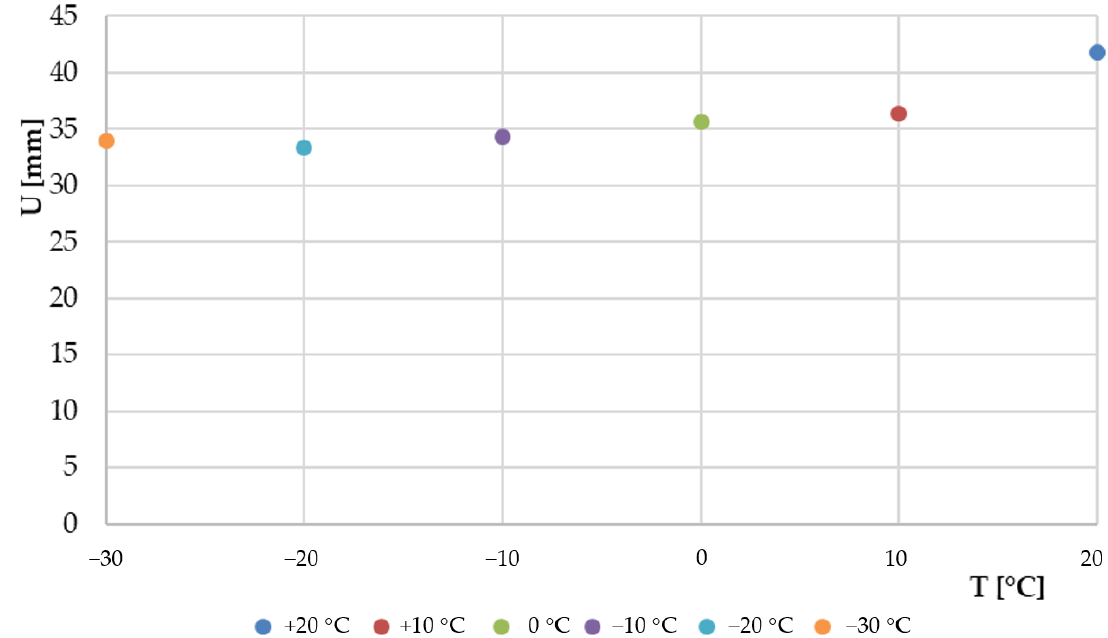
Figure 9. The maximum displacement of laminated windscreen due to head impactor impact as a function of temperature.